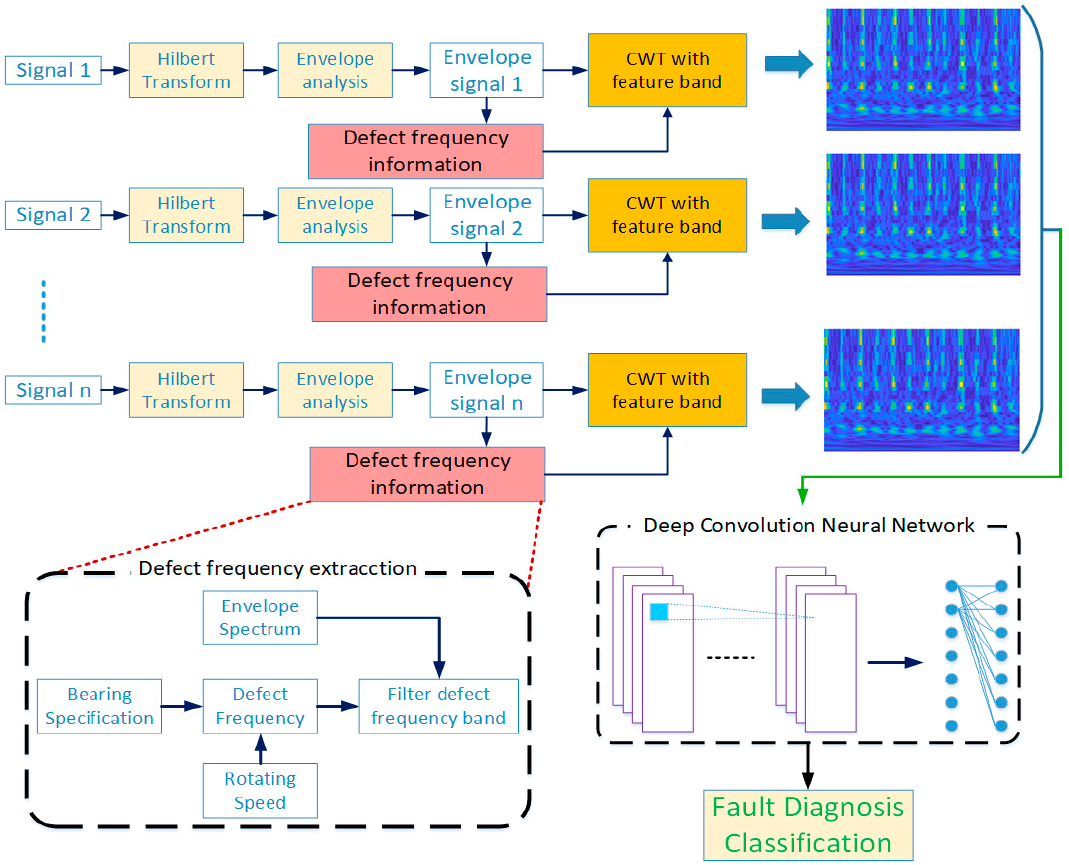
Figure 4. Generating the DSWI representation and process for fault diagnosis.